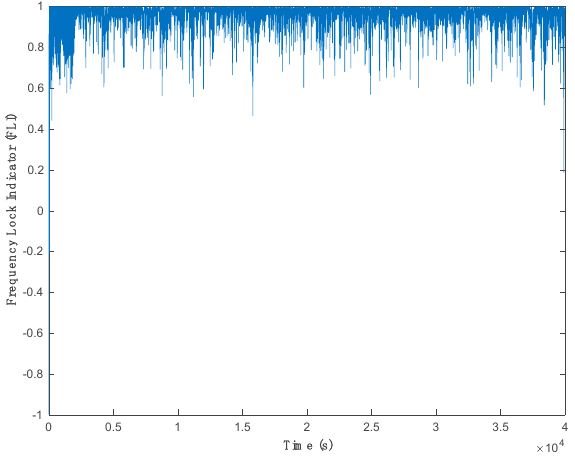
Figure 14. Estimated Doppler frequency of PRN 19.